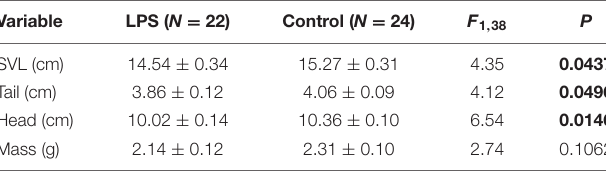
phenotypes of hatchlings in Experiment